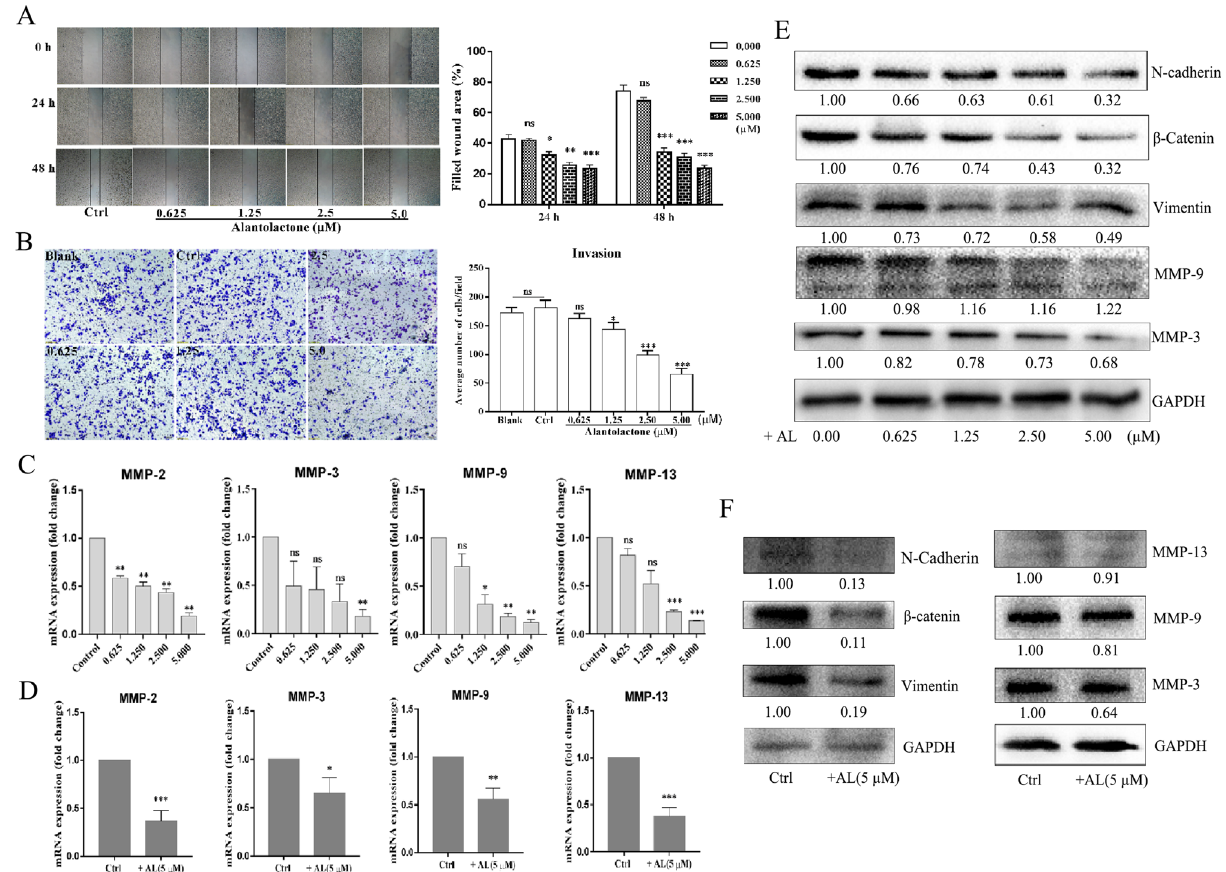
Figure 2. AL inhibits migration and invasion of cervical cancer cells. ( A ) The effects of AL on migration potential of HeLa cells were examined using wound healing assay. HeLa cells were seeded, scratched, and then treated with AL (0.625, 1.25, 2.5, and 5.0 μM) at indicated concentrations for 0, 24, and 48 h. The cells in the dish were examined and the scratches were measured using an optical microscope. Quantitative analysis of the scratch sizes in the wound healing assay, on the right. ( B ) The effects of AL on invasion potential of Hela cells were examined using transwell assay. Hela cells were seeded in the transwell boyden chambers and then treated with AL at indicated concentrations for 24 h. The cells that passed the transwell chamber were stained with crystal violet and examined using a light microscope. Quantitative analysis of the migrated number of cells in the transwell assay, on the right. ECM degradation enzymes (MMP-2, MMP-3, MMP-9, and MMP-13) were determined using western blotting in HeLa ( C ) and SiHa ( D ) cells. The protein levels of EMT molecular markers (N-cadherin, β-catenin, and vimentin) and ECM degradation enzymes (MMP-2 and MMP-9) were determined using western blotting in HeLa ( E ) and SiHa ( F ) cells. Here cropped blots were displayed and all full-length blots are included in the Supplementary Information file. * P < 0.05, ** P < 0.01, *** P < 0.001, vs